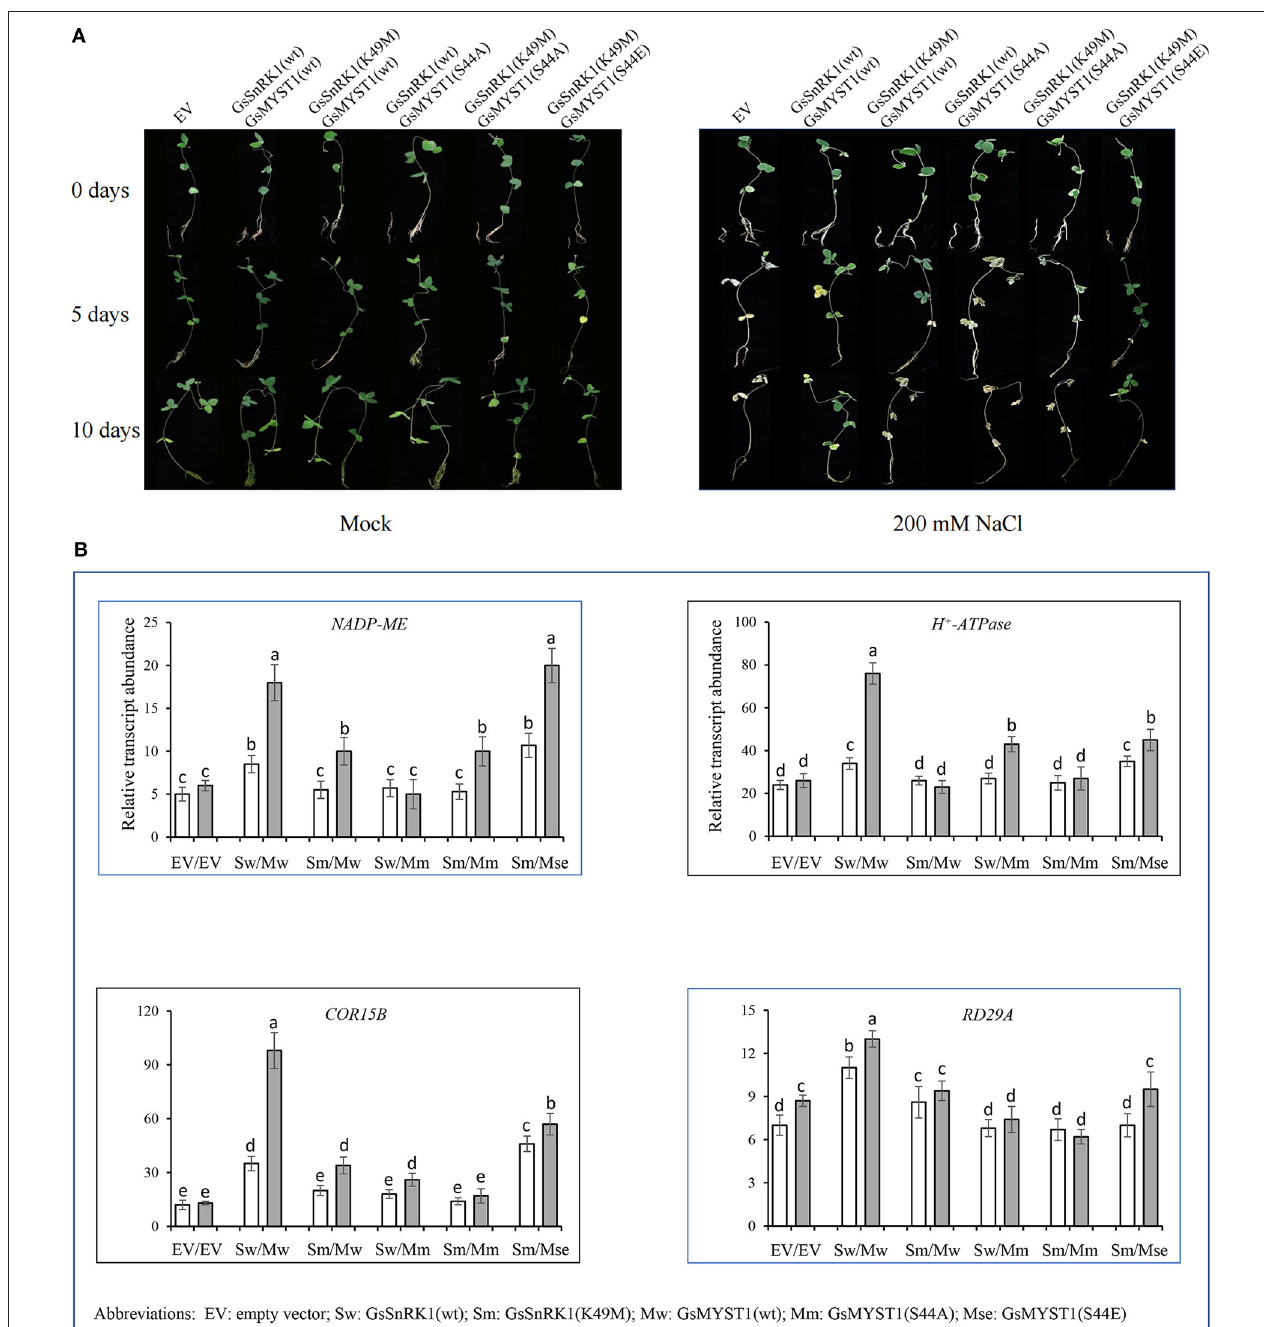
FIGURE 8 | GsSnRK1 and GsMYST1 enhance soybean resistance to salt stress. (A) GsSnRK1 (wt), GsMYST1 (wt), and their mutants were cotransformed into soybean hairy roots followed by treatment of 200mM for 5–10 days. The phenotypes of representative plants were observed and compared. Each representative figure was shown from three biological triplicates. (B) The expression patterns of four stress-related genes from soybean hairy roots cotransformed with the indicated genes. Bars indicate SE, the t-test, and the columns were shown from three biological triplicates ( t -test, p < 0.05, expressed in different small letter alphabets).